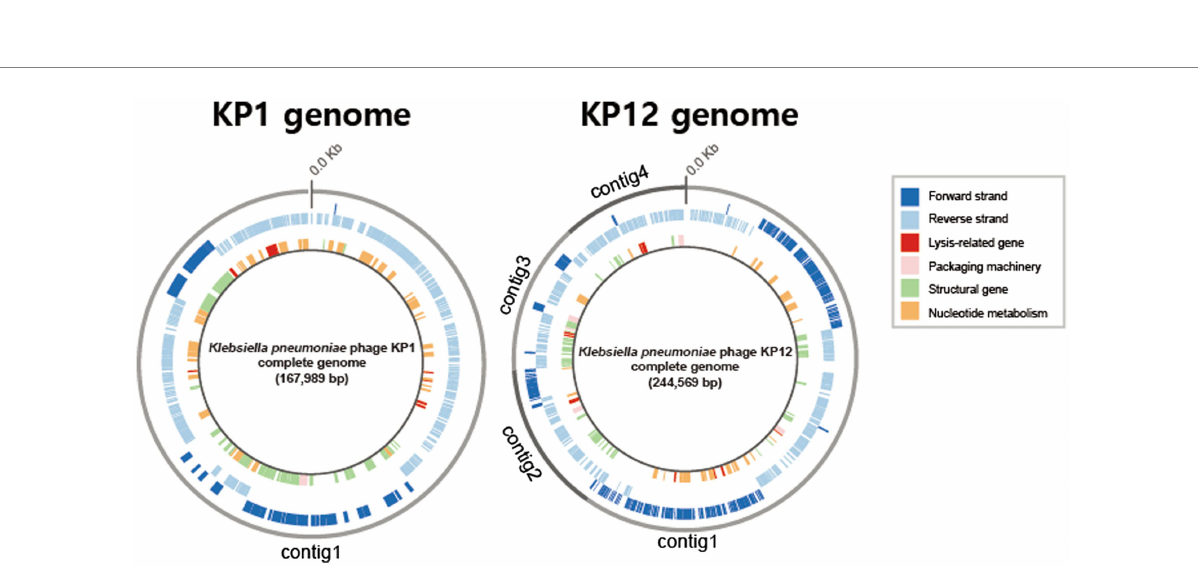
FIGURE 3 Circular representations of the bacteriophage KP1 and KP12 genomes. Outermost circle (gray) indicates the organization of contigs in this representation, followed by circles of forward (dark blue) and reverse (light blue) strands. Innermost circle are genes of putative functional categories, defined based on RASTtk annotation and are color coded (top